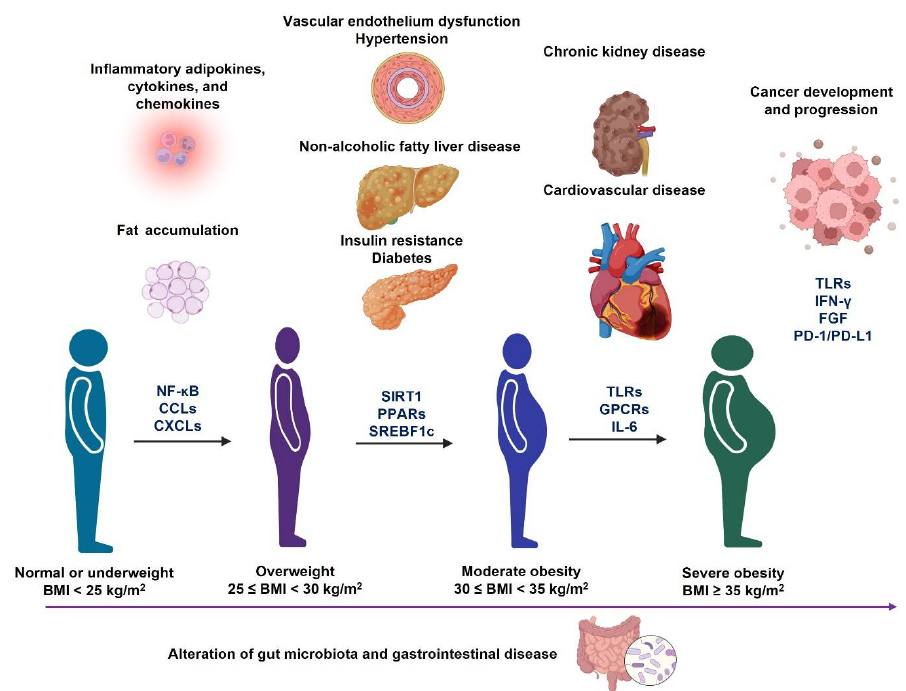
Figure 3. Different metabolic disorders accompany the development and progression of obesity. During the progression of obesity from overweight to severe obesity, it may cause different metabolic disorders, which are associated with the alteration of gut microbiota profiles. In addition, the molecular signaling pathways (Figure 2) may also change during the progression of each obesity-associated comorbidity.